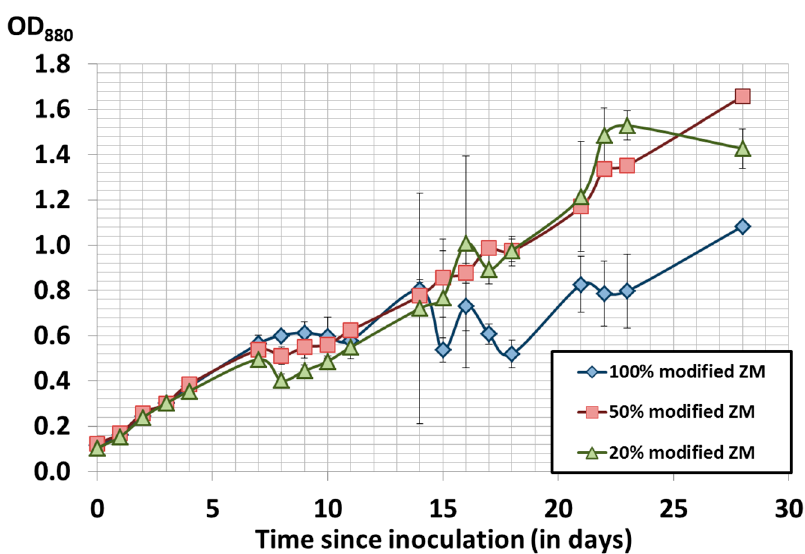
Figure 3. OD 880 measurements of Spirulina grown in 100% (blue diamonds), 50% (red squares), and 20% (green triangles) modified ZM, triplicates. Error bars are standard deviations of the biological triplicates.